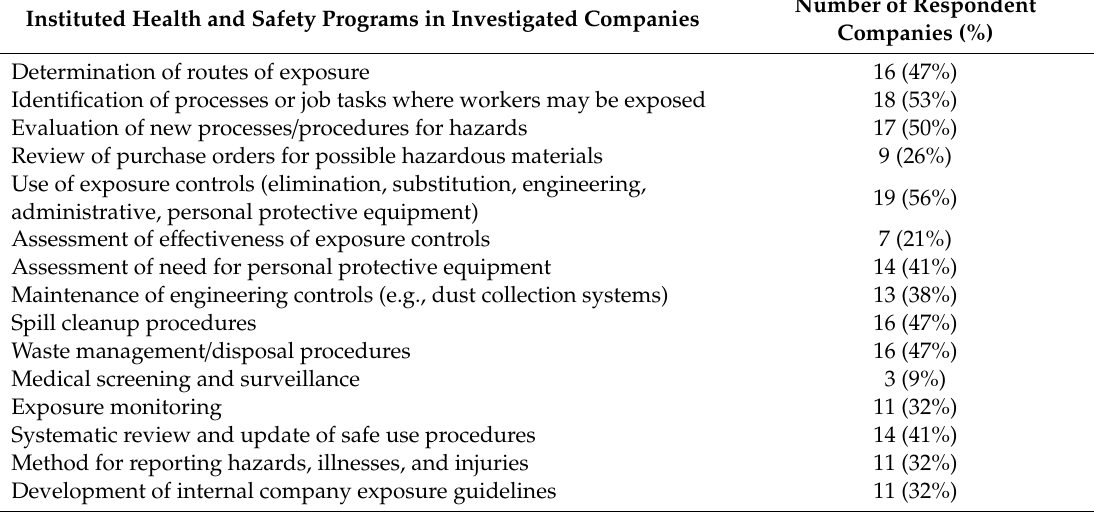
Table 3. Summary of the instituted health and safety